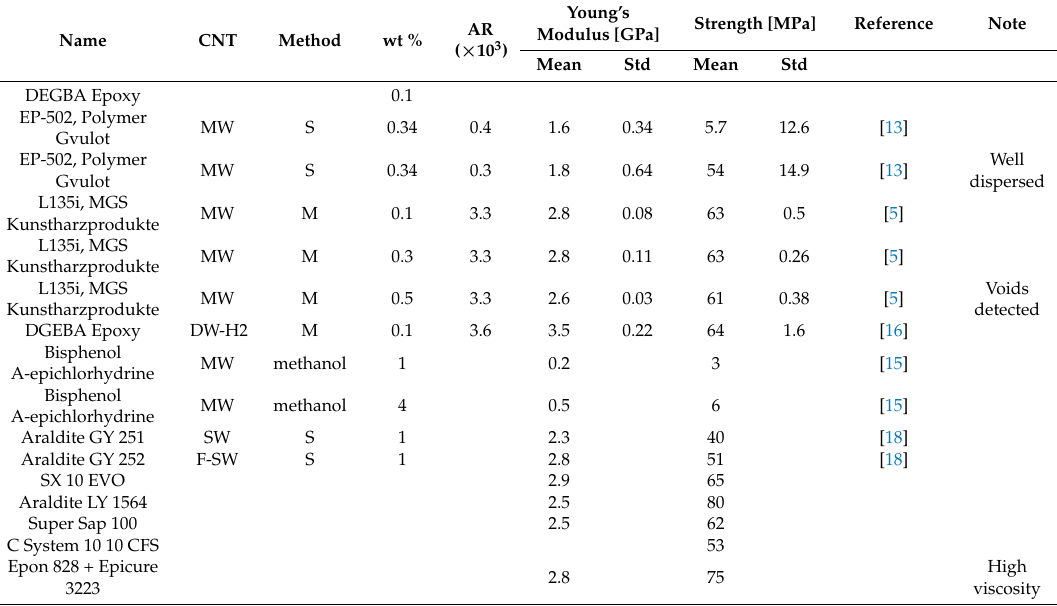
Table 1. Mechanical characteristics of commercially available epoxy resins and CNT-enhanced epoxy in open literature. S stands for sonication, M for mechanical. The mechanical properties are all related to tensile